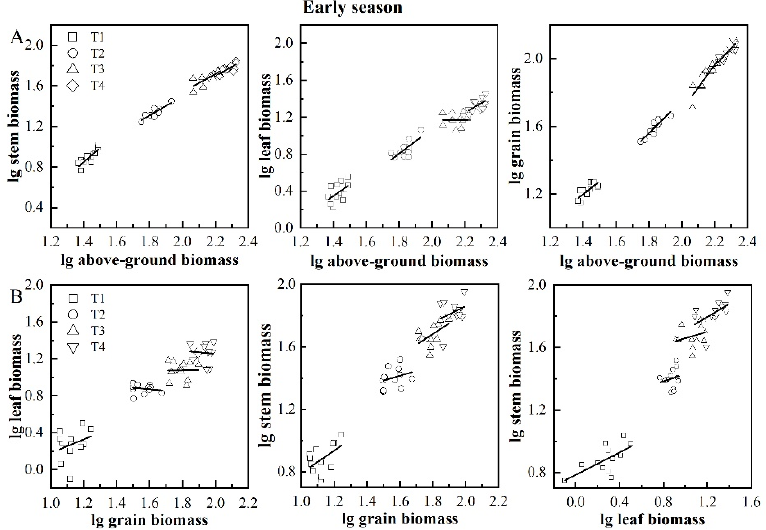
Figure 4. The allometric relationship between total aboveground biomass and organ biomass ( A ) and between organ and organ biomass ( B ) in early season rice. Note: T1, 1 seeding per hill + row spacing 12.93 cm; T2, 3 seedings per hill + row spacing 22.33 cm; T3, 6 seedings per hill + row spacing 31.67 cm; T4, 9 seedings per hill + row spacing 38.80